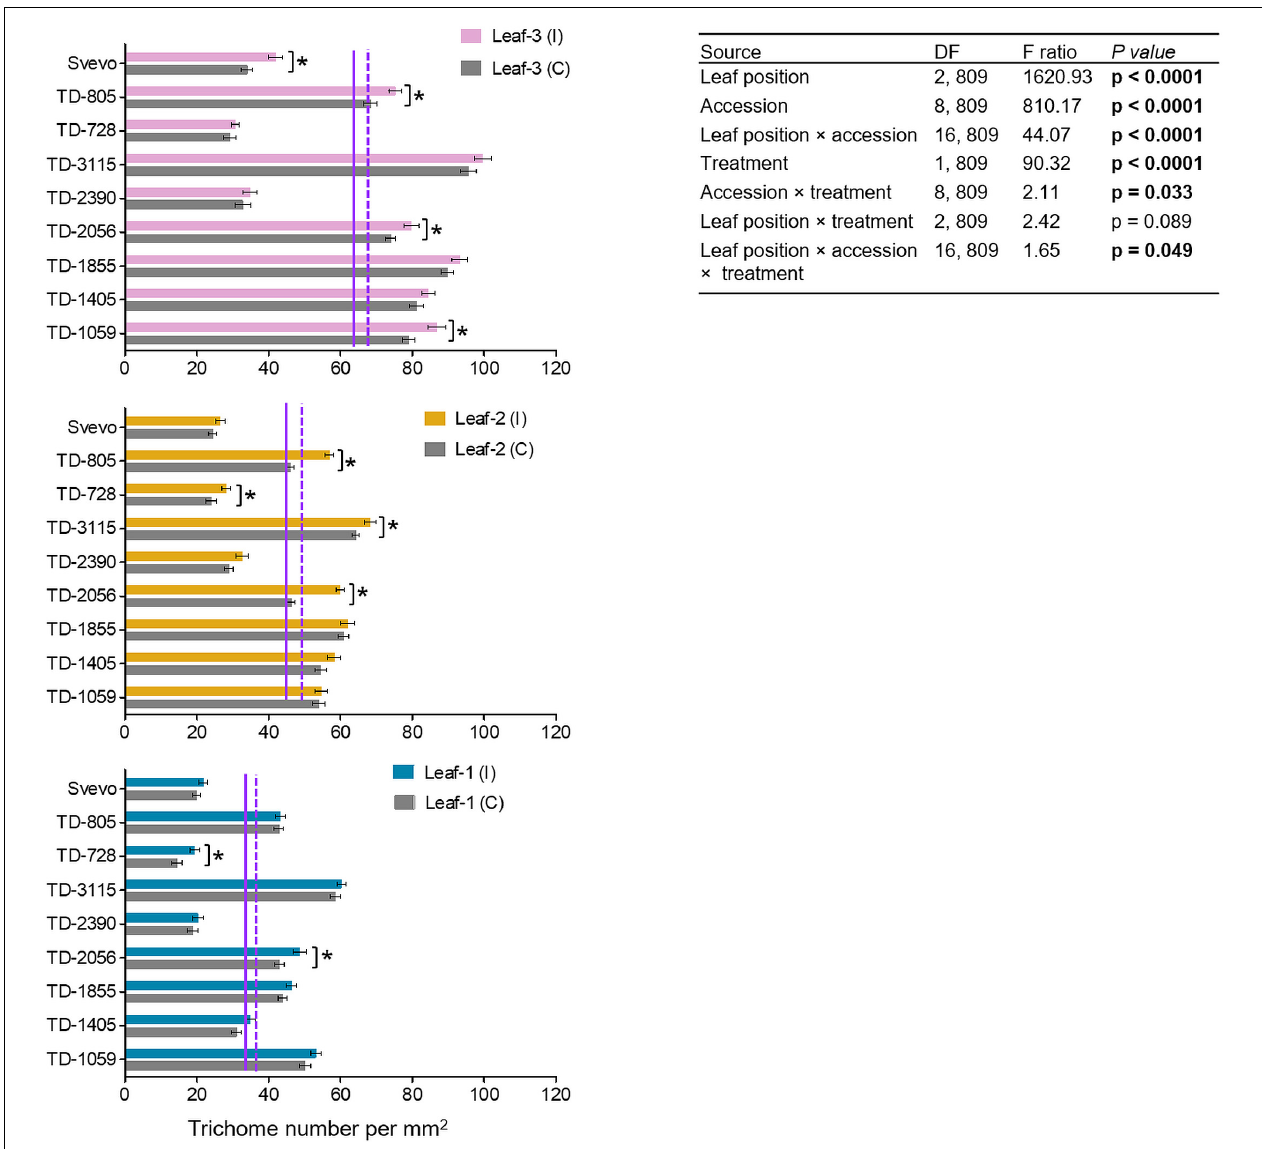
FIGURE 3 | Trichome densities of nine selected wheat genotypes. Trichome density per mm 2 was evaluated in leaf-1, leaf-2, and leaf-3 in both the untreated control (C) and 96 h following infestation (I) with R. padi using the choice whole cage bioassay. Values are expressed as mean ± SE ( n = 5 replicate with three images per replications). The solid and dashed purple lines represent the mean value of each leaf type under the untreated control and infested conditions among the accessions, respectively. The effects of leaf position, accession, treatment, and their interaction (leaf position × accession × treatment) were tested by two-way ANOVA analyses. The asterisk represents the significant difference between treatments in a particular accession analyzed by Student’s t -tests ( p < 0.05). In bold are the parameters that were significantly affected, p <